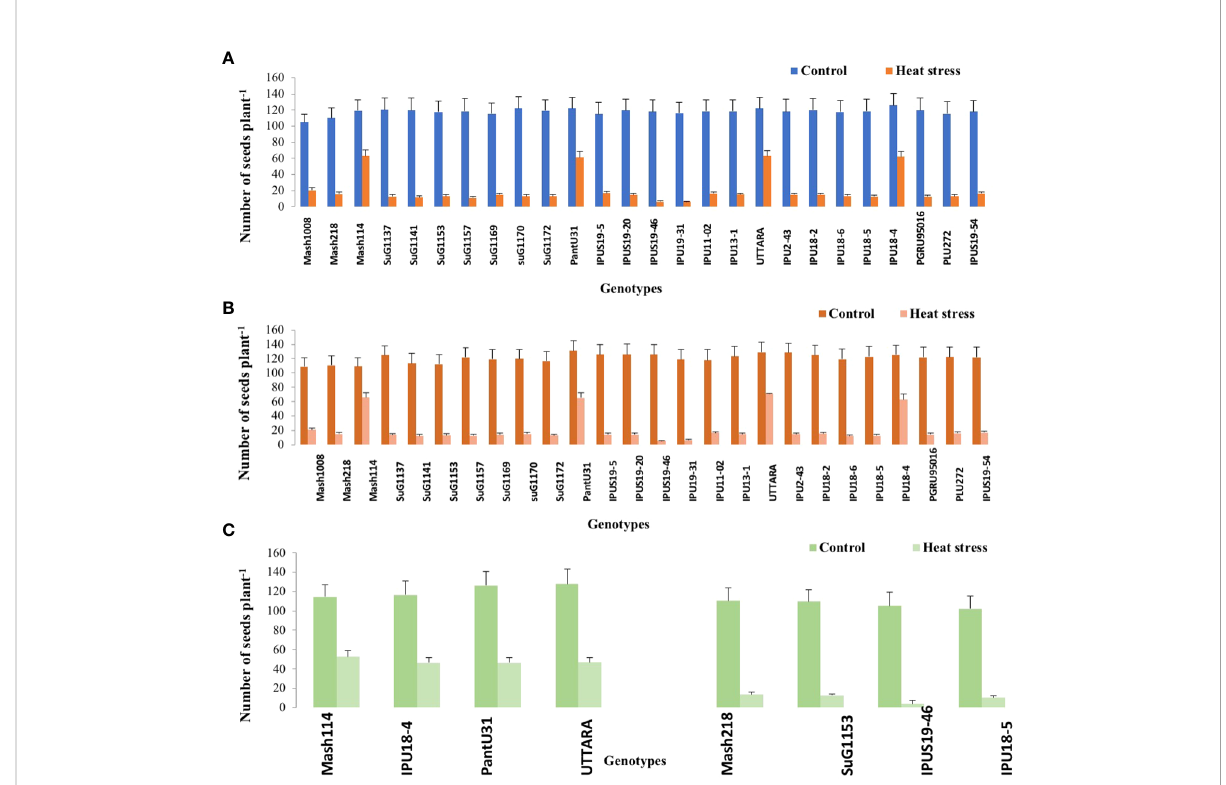
FIGURE 2 Seed number plant -1 of Urdbean genotypes under control (normal-sown; Control) and heat stress environment during 2018 (A) ,2019 (B) and in controlled environment of growth chamber ( C ; GC). LSD values (P < 0.05); genotype × treatment:6.9 (2018), 7.5 (2019), 12.1 (GC). Values are means + SE. (n =